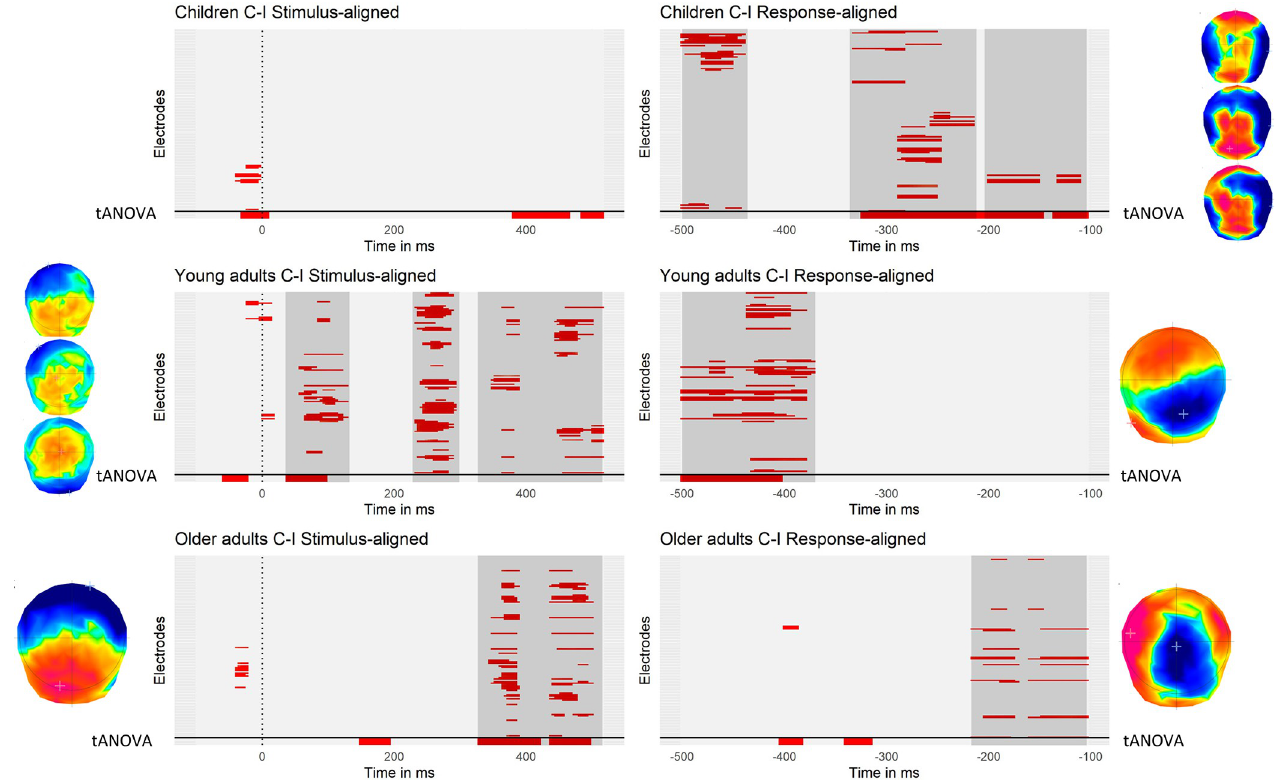
Fig 3. Significant differences in the contrast between congruent and incongruent conditions on each electrode and time-point for stimulus- and response-aligned ERPs within each age-group. The dotted vertical line represents the onset of the stimulus and the signal under the horizontal solid line at the bottom of each plot represents the tANOVA results specific to each contrast. Periods of consecutive significance shorter than 4 time frames (~16ms) were discarded. Clusters of significance are highlighted in gray. The topographies on the side represent the spatial distribution of the significant electrodes constituting the different